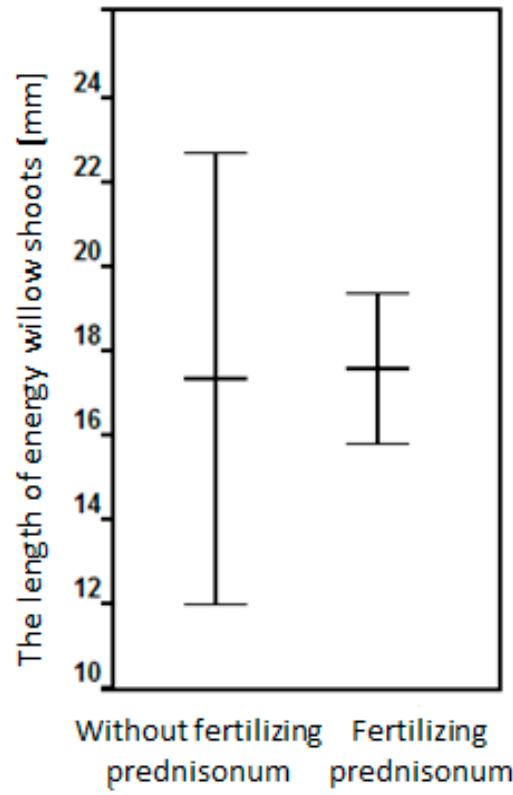
Figure 5. Significance of the effect of prednisonum fertilization on the length of energy willow shoots. Source: Own study. Table 3. Physical characteristics of prepared